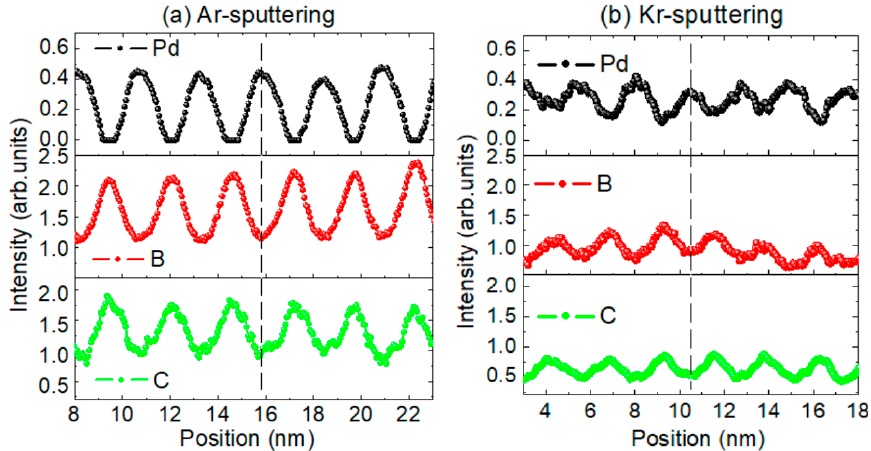
Figure 5. Transmission electron microscopy (TEM) and selected area electron diffraction (SAED) images of the 150-bilayer multilayers fabricated by Ar ( a , c , e ) and Kr ( b , d , f ).